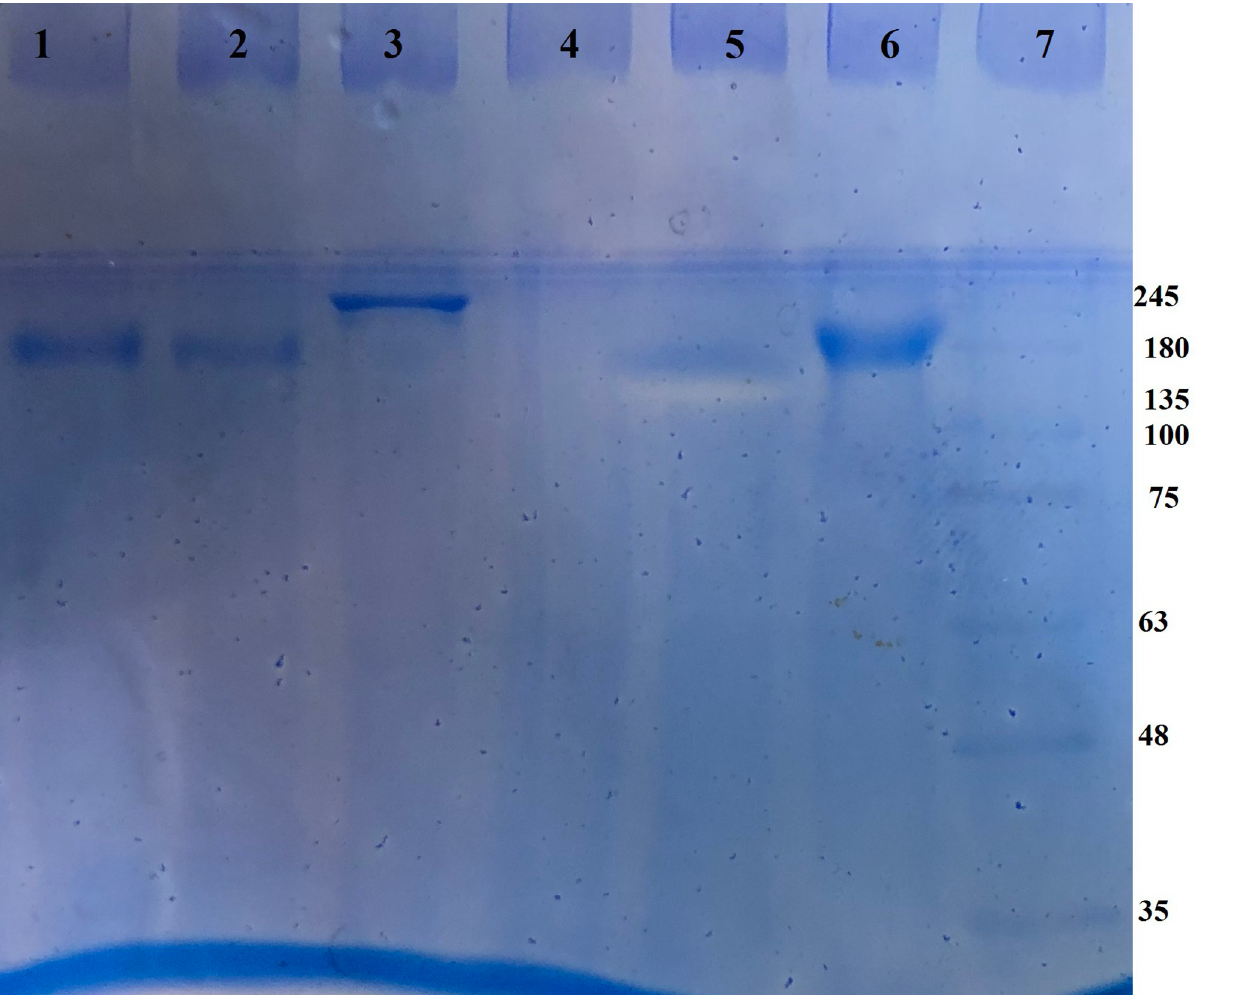
Fig 1. The SDS-PAGE analysis of the antibody conjugation with E . coli antigens and doxorubicin. The anti-MCF7 antibody (lane 1 and 2), antibody conjugated to E . coli antigens (lane 2), blank (lane 4 and 5) and antibody conjugated to doxorubicin (lane 6); lane 7 shows the protein molecular weight ladder.